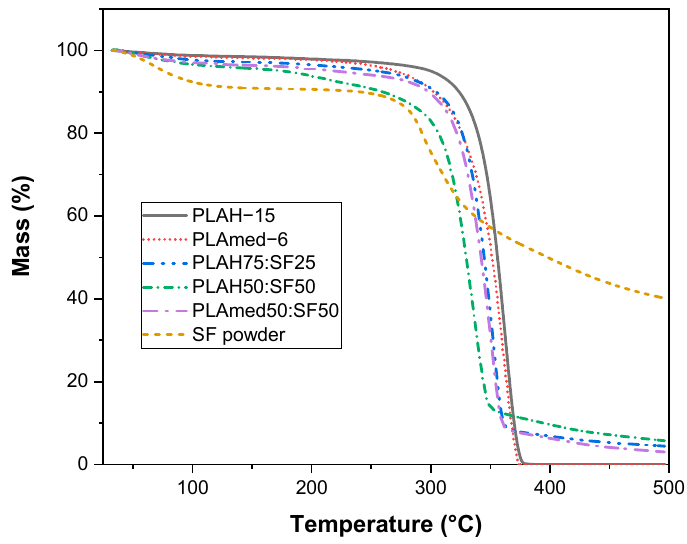
Figure 6. TGA thermograms of SF, PLAH − 15, PLAH75:SF25, PLA50:SF50, PLAmed − 6, and